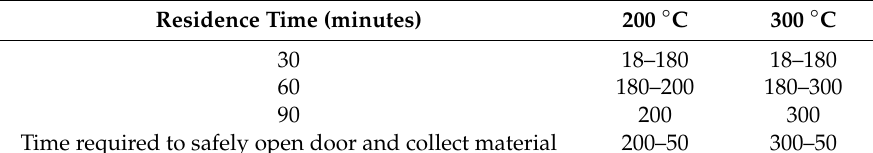
Table 3. Temperature and residence times used in the tests.